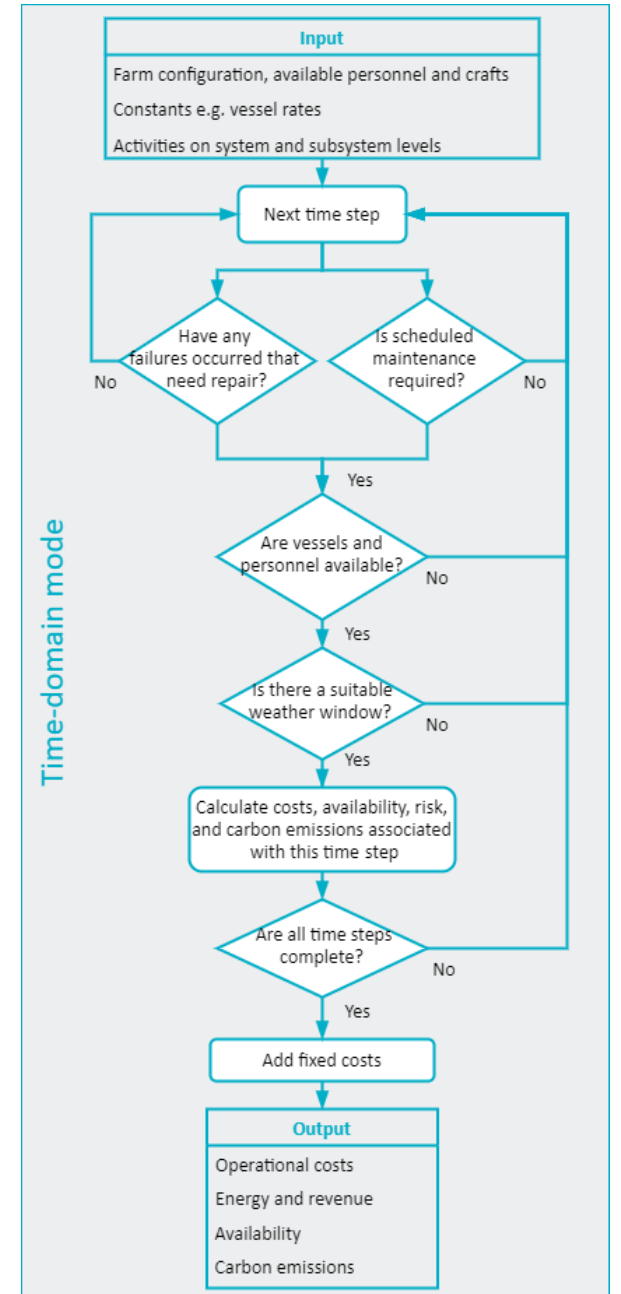
Figure 1. COMPASS tool workflow when operating in the time- domain